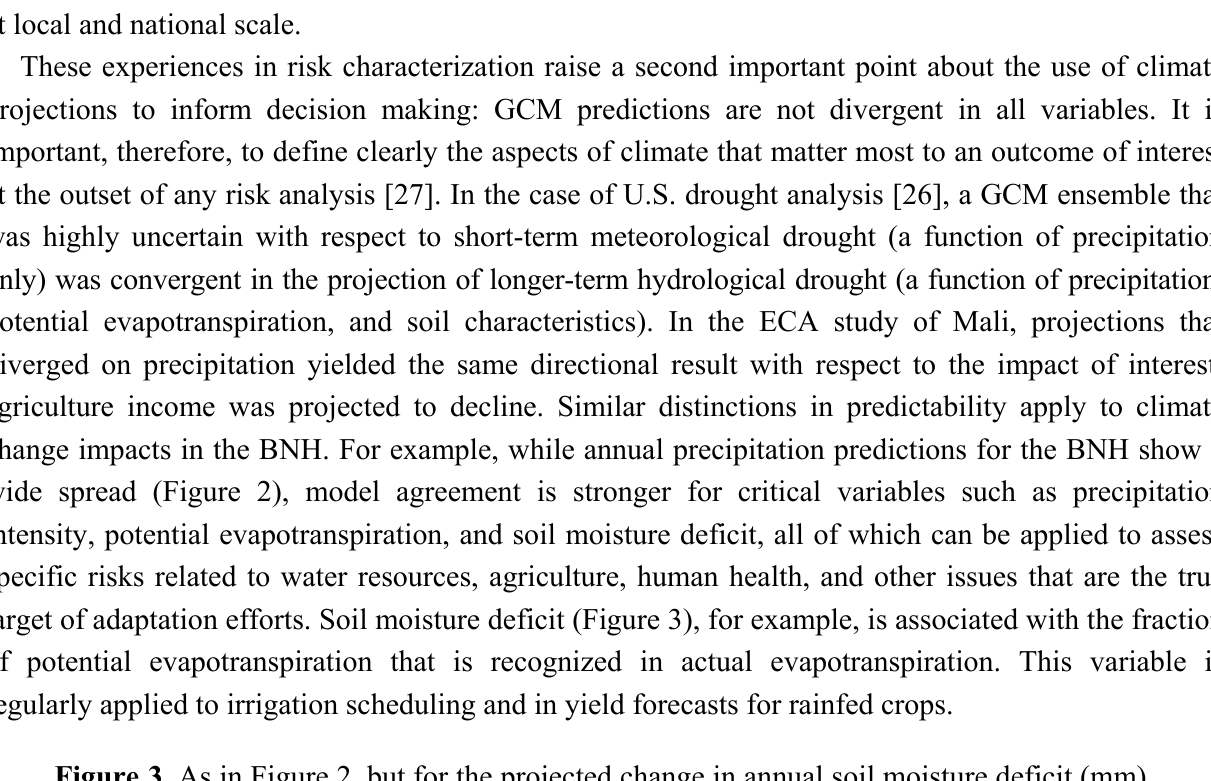
Figure 3. As in Figure 2, but for the projected change in annual soil moisture deficit